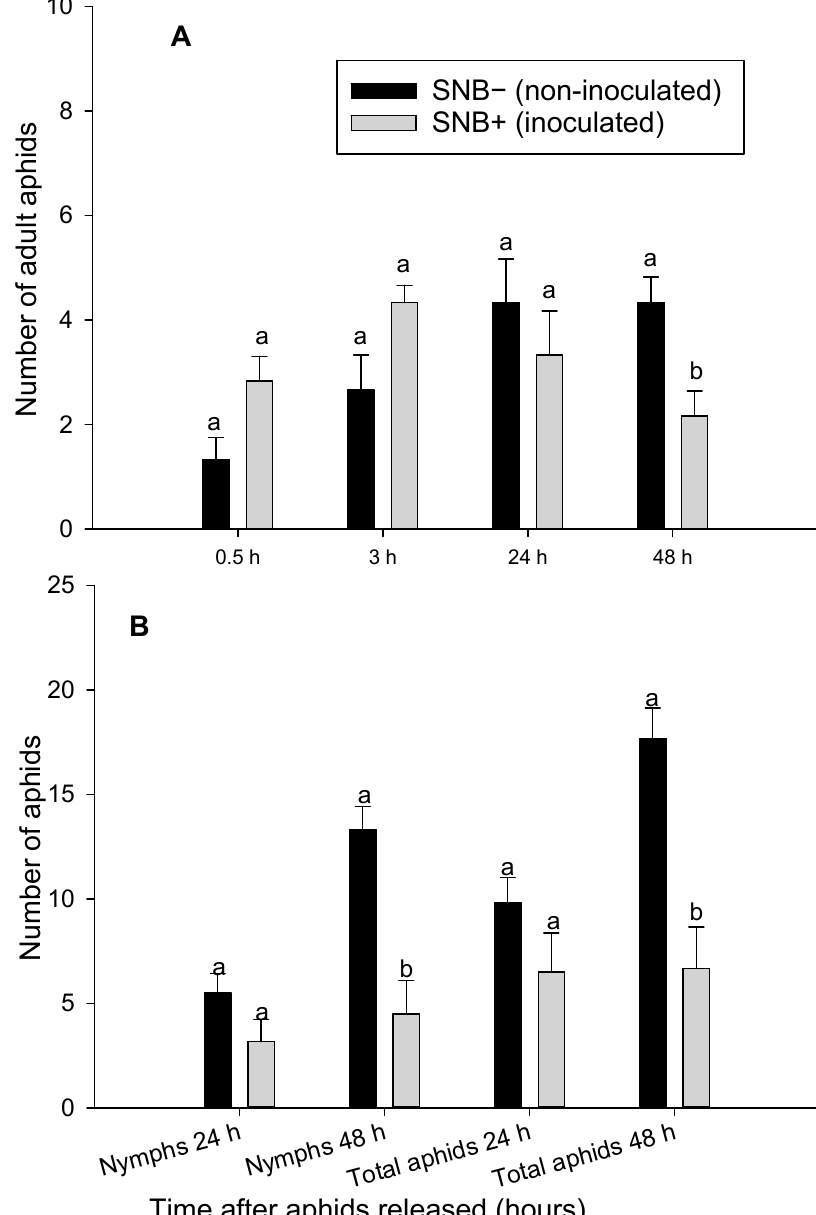
Figure 5. Number of adult aphids ( Rhopalosiphum padi) ( A ) and number of adult aphids and nymphs ( Rhopalosiphum padi) ( B ) on Stagonospora nodorum blotch inoculated (SNB+) and non-inoculated (SNB − ) leaves of wheat 0.5, 3, 24 and 48 h after adult female aphid release. Results from experiment 1. Error bars are standard error of the mean values and bars with different letters within the same treatment group are statistically different at p = 0.05.